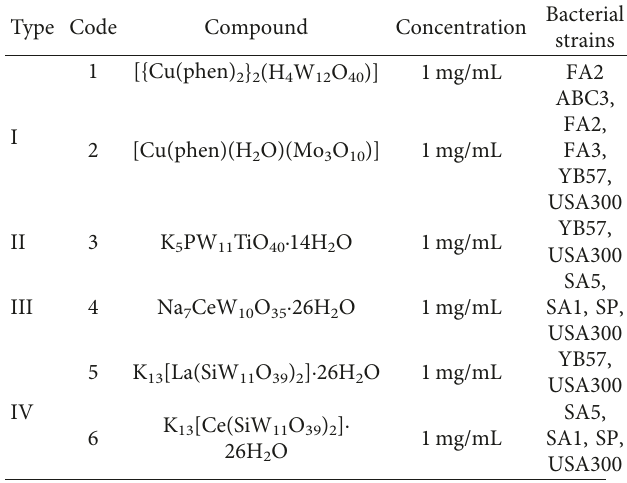
Table 2: Cu-O and Cu-N bond lengths (˚A) in 1 . Bond Length Bond Length